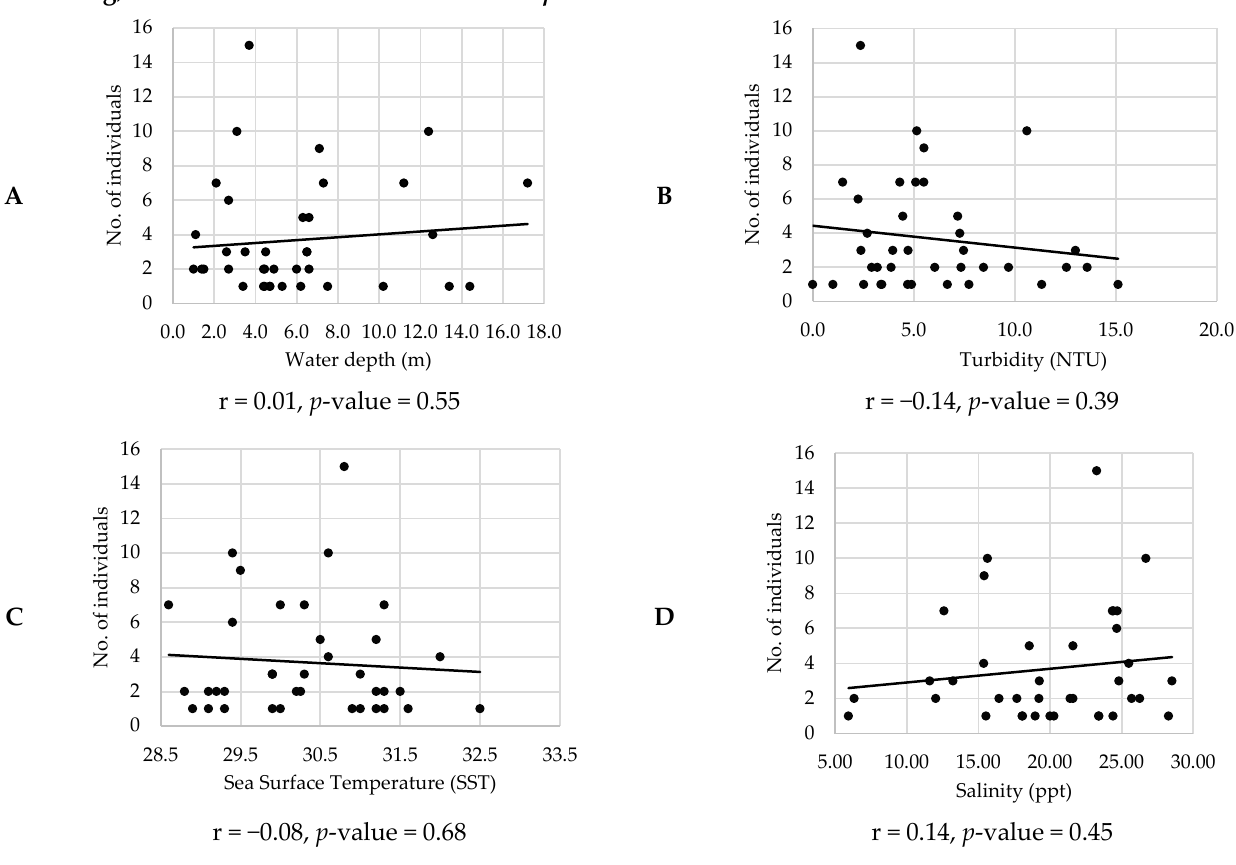
r = − 0.08, p -value = 0.68 r = 0.14, p -value = 0.45 Figure 10. The number of individuals in a group of Irrawaddy dolphins displaying travelling behaviour versus abiotic factors (depth ( A ), turbidity ( B ), SST ( C ) and salinity ( D )).